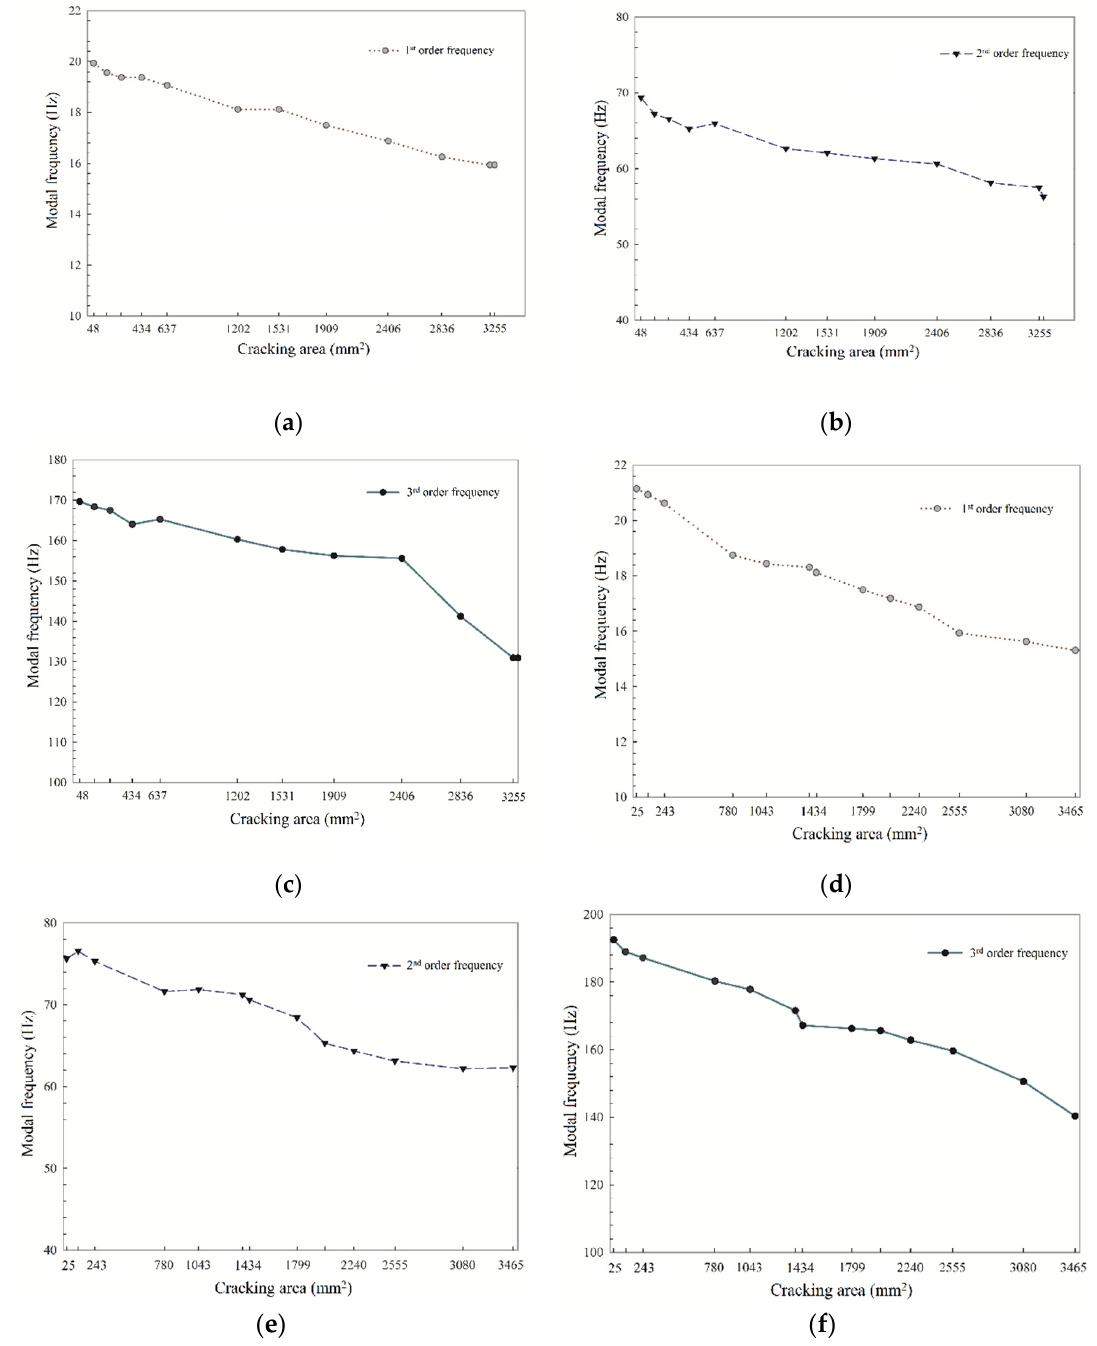
Figure 9. First three order natural frequencies of the two RC beams affected by cracking area: ( a ) first-order frequency of the 1 # beam; ( b ) second-order frequency of the 1 # beam; ( c ) third-order frequency of the 1 # beam; ( d ) first-order frequency of the 2 # beam; ( e ) second-order frequency of the 2 # beam; ( f ) third-order frequency of the 2 # beam.